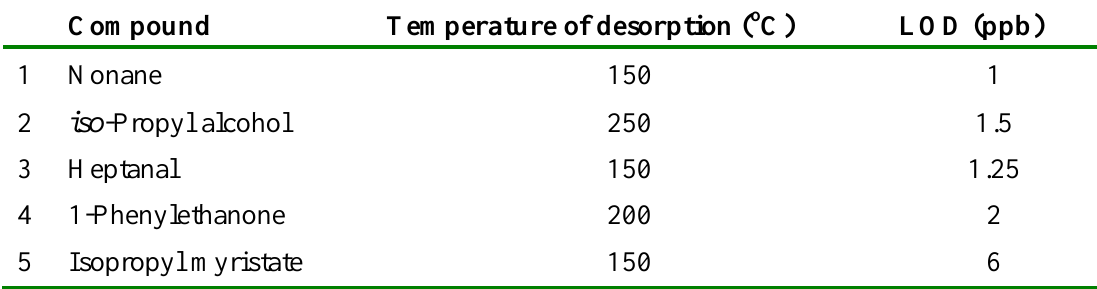
Table 3. Limits of Detection (LOD) using the integrated pre-condensation and e-nose system. Sample volume is 1 L; trapping temperature is 12 o C, the trapping flow rate is 100 mL/min; desorption flow rate is 50